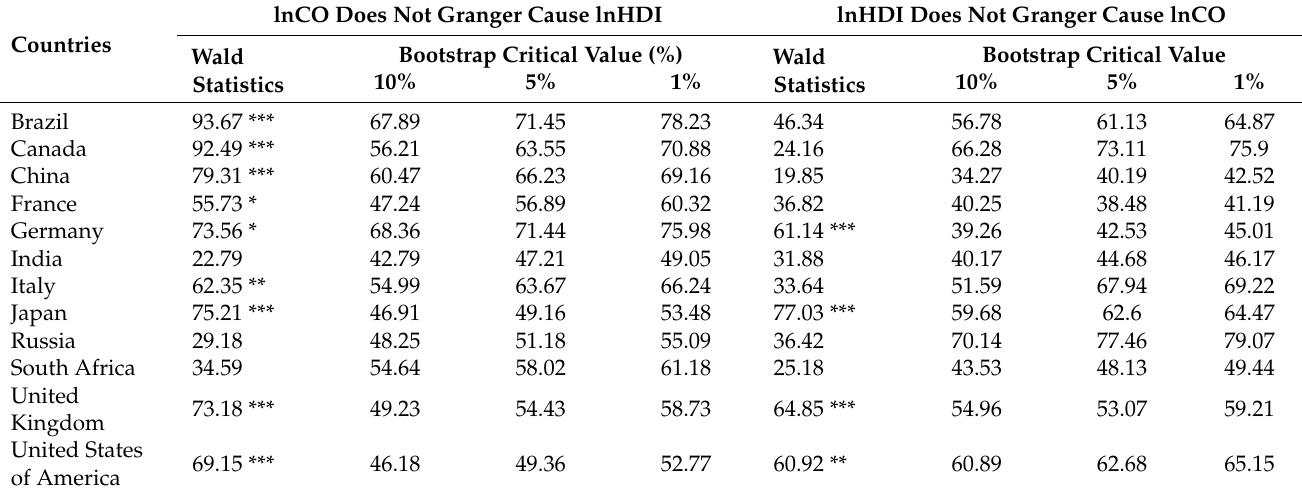
Table 9. Bootstrap Granger causality test between lnCO and